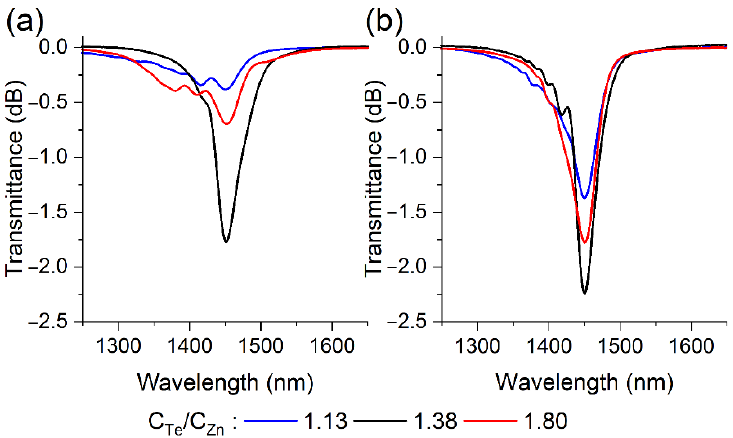
Figure 4. Transmission spectra of thinned optical fibers coated with thin ZnTe films for ( a ) TE and ( b ) TM LMRs at different C Te /C Zn ratios.